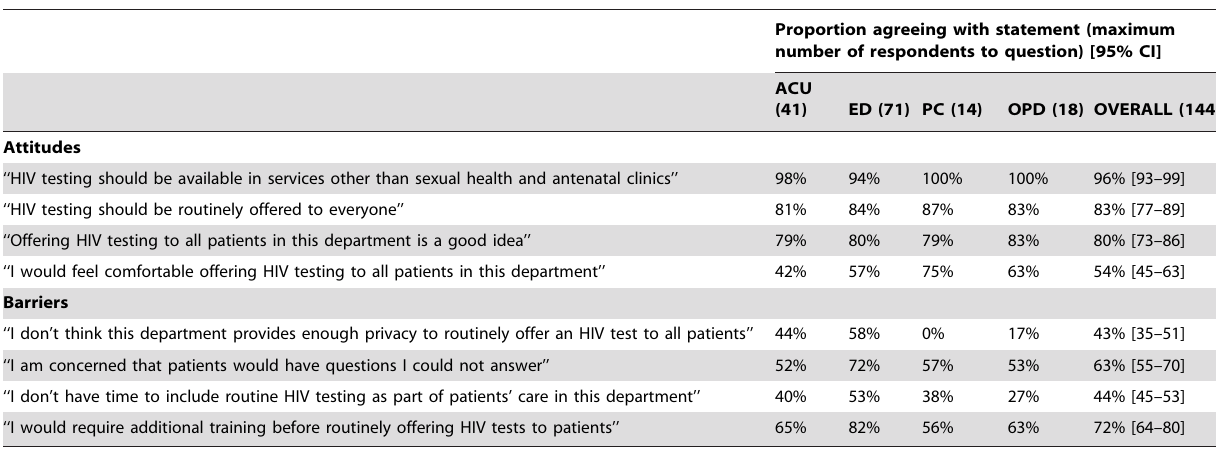
Table 2. Staff attitudes and barriers to the provision of HIV tests in non-specialist settings.